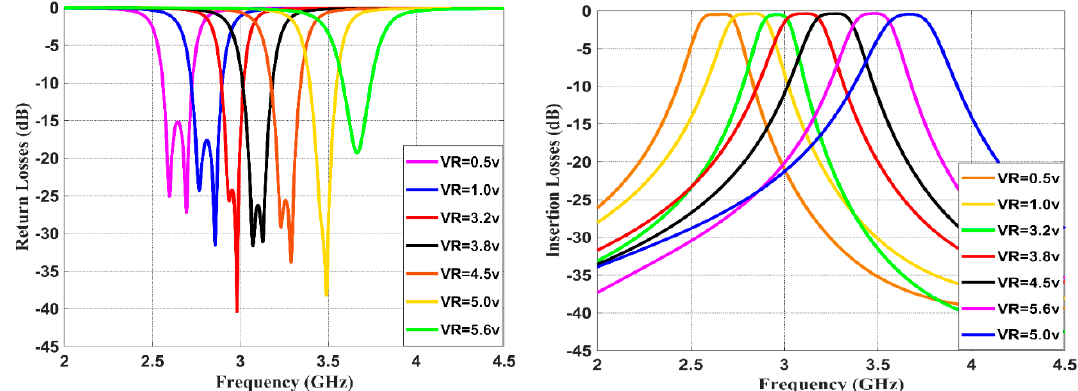
Figure 6. S-parameter performance of the reconfigurable filter reproduced from [36]. 2020, IEEE with a photograph of the prototype.